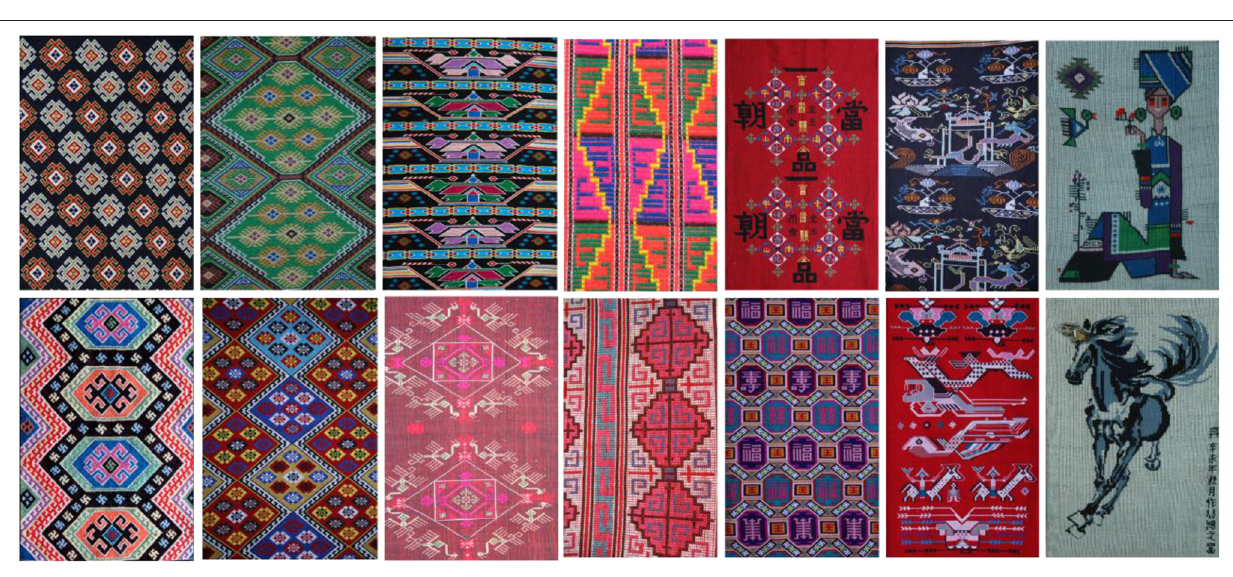
FIGURE 7 | Tujia brocade